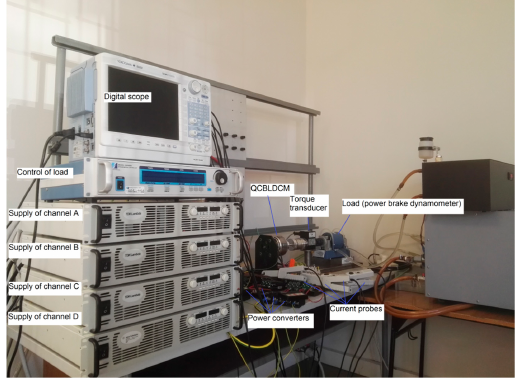
Figure 14. Stand for transient test of a QCBLDC motor.